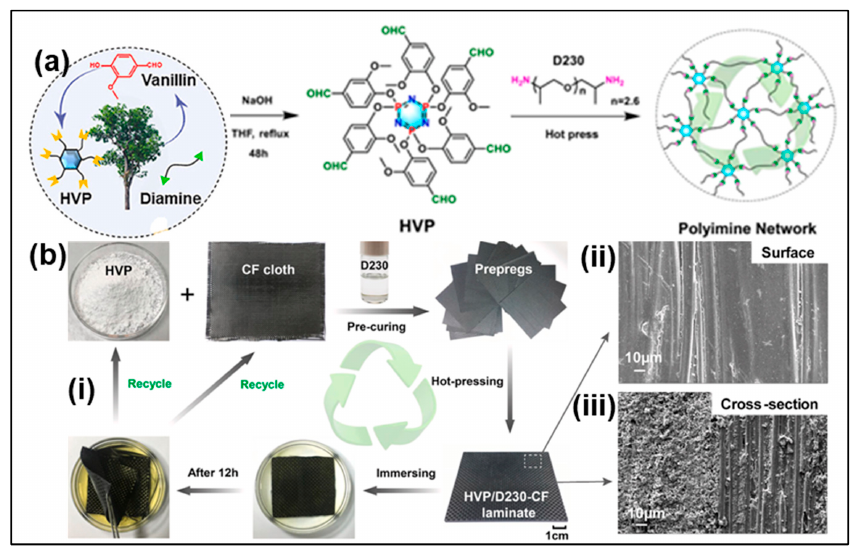
Figure 10. ( a ) Synthesis procedure of polyimine vitrimer; ( b ) formation of HVP/D230-CF composite and its upcycling (i), and SEM image (ii) surface and (iii) cross-section [reproduced with permission from Liu et al.; published by Elsevier, 2021] [51].